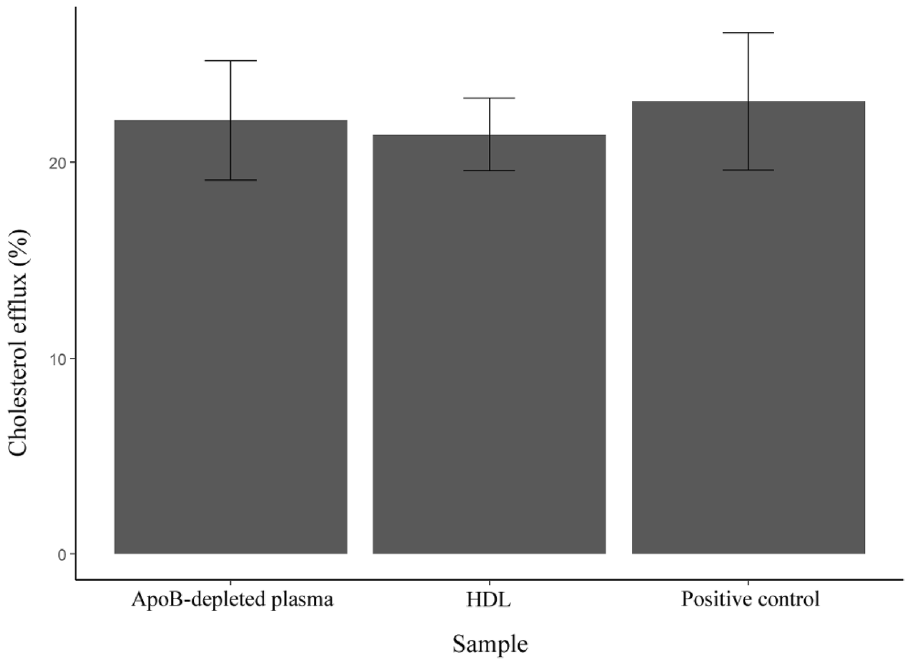
Figure 8. Comparison of the cholesterol efflux capacity of isolated HDL, ApoB-depleted plasma, and a positive control. HDL samples isolated by the current method has a comparable cholesterol efflux capacity (21.4 ± 1.3%) compared to that of ApoB-depleted plasma (22.1 ± 2.5%) or a positive control (23.1 ±